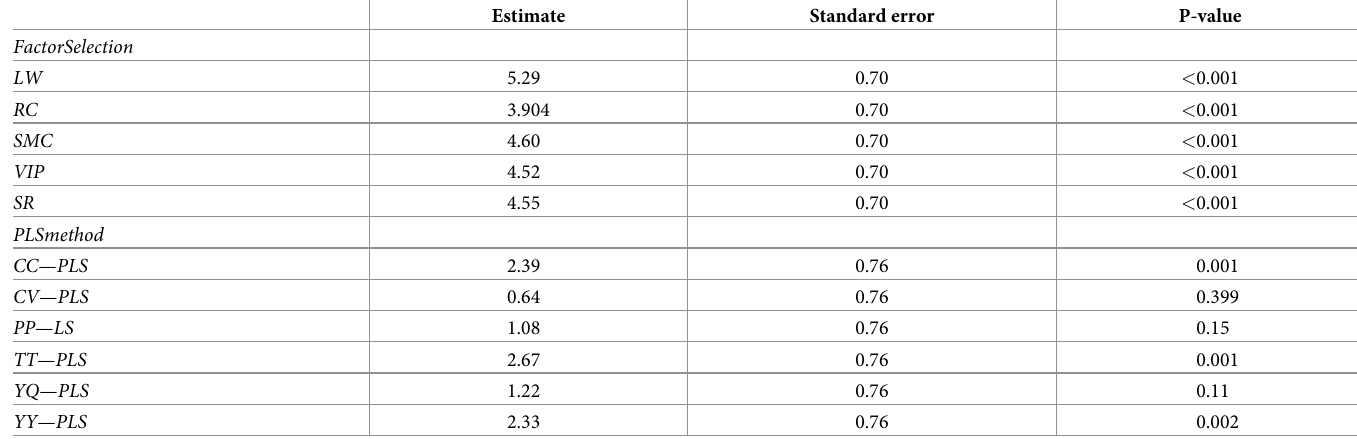
Table 1. Anova results showing the significance of PLS methods and factor selection measures in explaining the variation in accuracy of the models are presented. Estimate